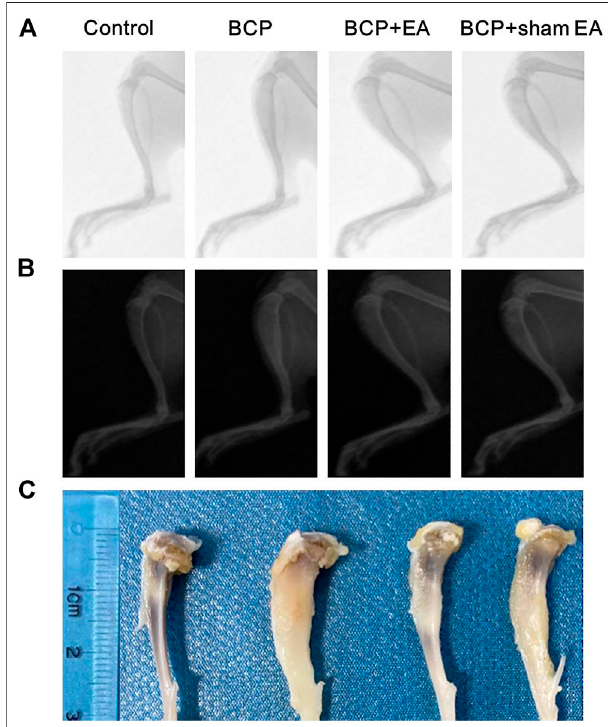
FIGURE 2 | Radiographs of the tibial bone inoculated with PBS (control) or MRMT-1 mammary gland carcinoma cells (BCP). (A) X-ray radiographs of the ipsilateral tibial bone on the 16th day after carcinoma cell inoculation; (B) the invert X-ray radiographs ofthe ipsilateral tibial bone on postoperative day16; (C) grossanatomyoftheipsilateralrattibia.Thescalerulerwasshown on the left of the tibia